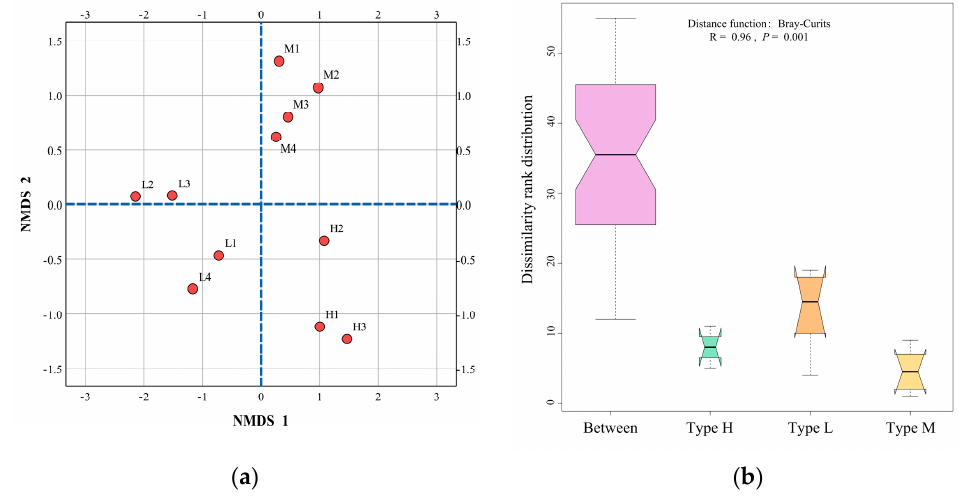
Figure 3. NMDS plot of macrobenthic density at the different survey locations (stress = 0.042). H1–H3, M1–M4, and l1–l4 indicate the survey locations in the Euryale ferox artificial planting area (type H), the Trapa spp. natural growth area (type M), and the control area (type L), respectively ( a ). ANOSIM analysis results of R > 0 and p < 0.01 denote that the differences between groups were significantly greater than those within groups ( b ).